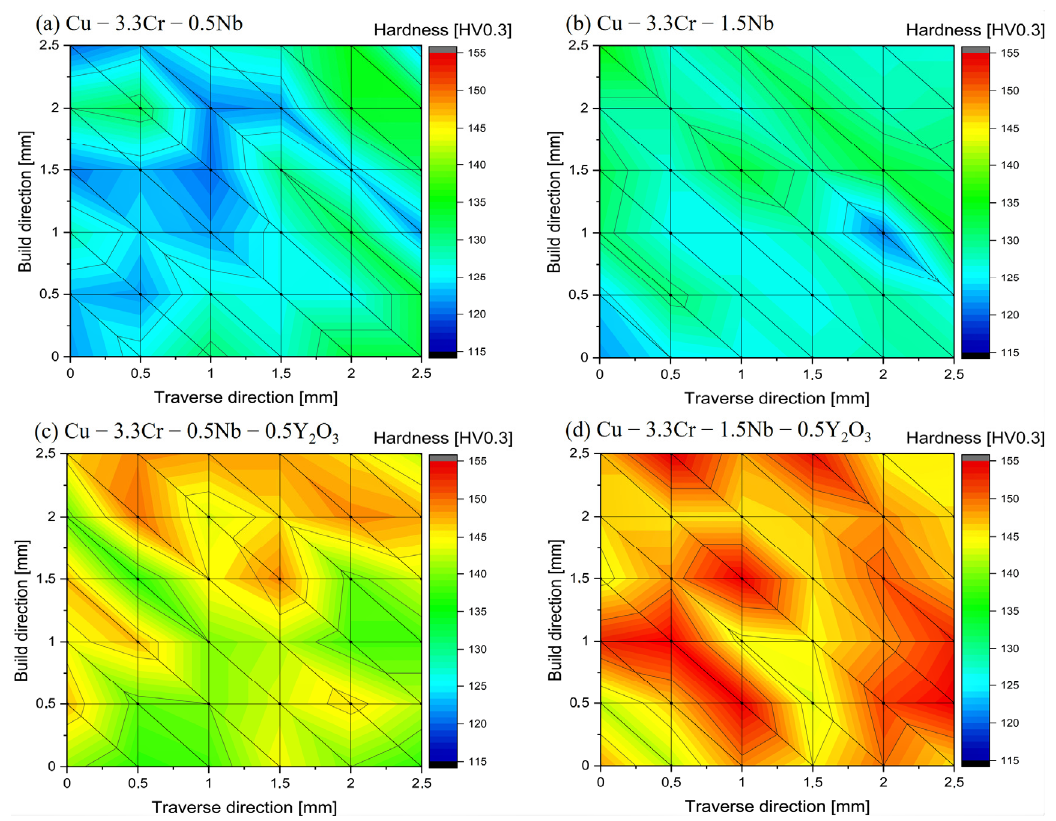
Figure 7. Vickers hardness (HV0.3) maps of manufactured specimens in the as-printed state. ( a ) Cu-3.3Cr-0.5Nb. ( b ) Cu-3.3Cr-1.5Nb. ( c ) Cu-3.3Cr-0.5Nb-0.5Y 2 O 3 . ( d ) Cu-3.3Cr-1.5Nb-0.5Y 2 O 3 . The hardness between the individual hardness indents is linearly interpolated.